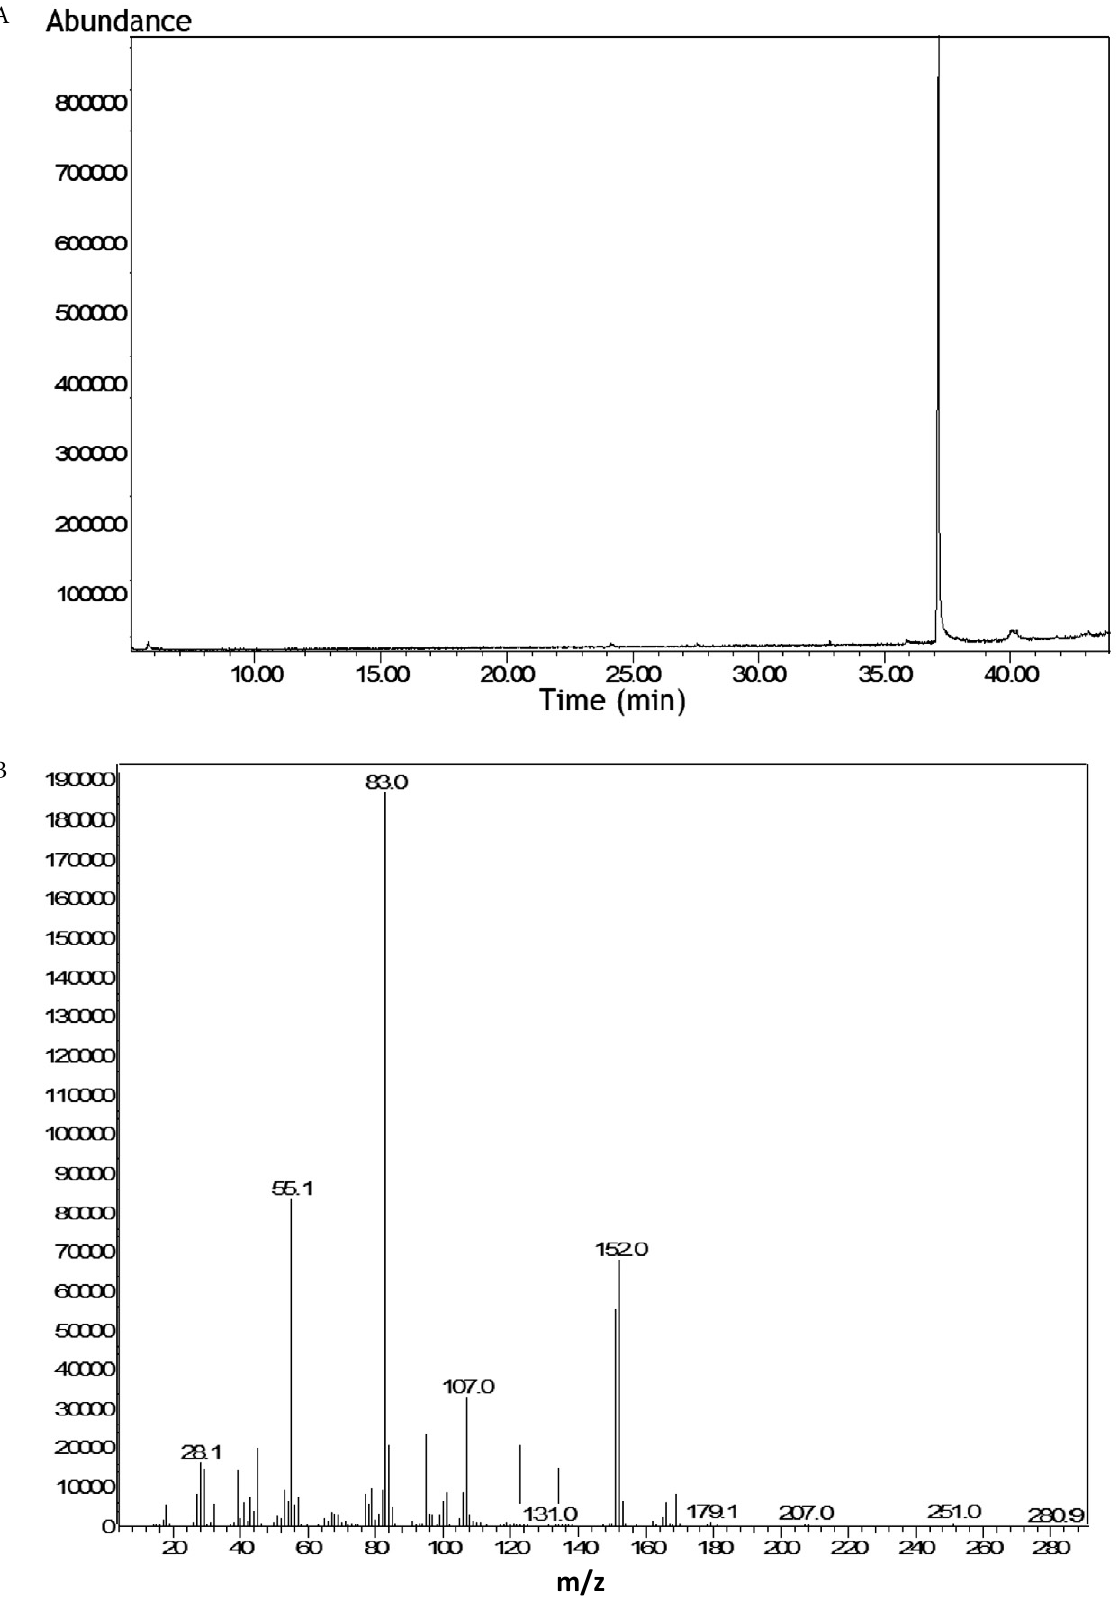
Figure 3. Total ion chromatogram (A) and GC/MS spectra (B) of compound